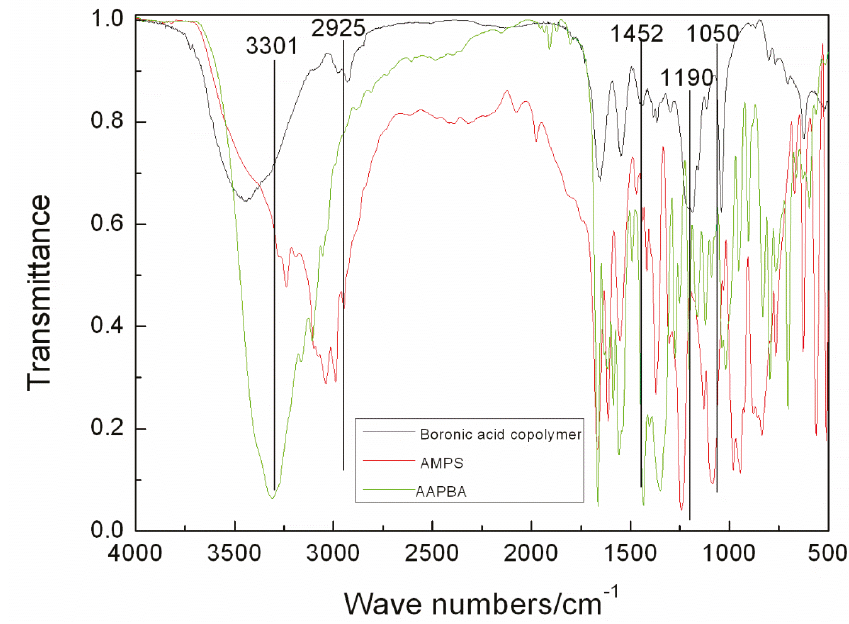
Figure 1 Fourier transform infrared (FTIR) spectrum of boronic acid copolymer. Figure 1. Fourier transform infrared (FTIR) spectrum of boronic acid